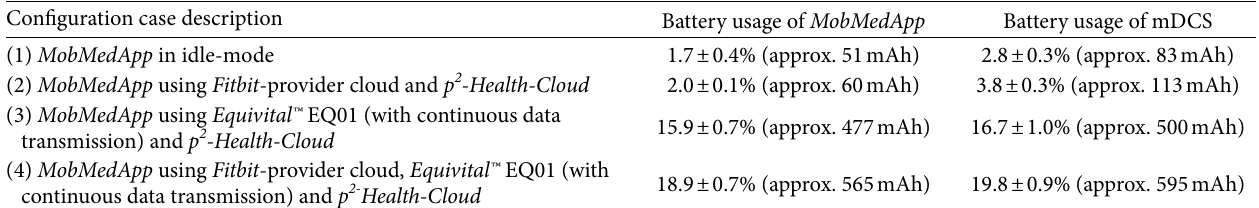
Table 1: Battery usage of mDCS ( MobMedApp ) for different configuration cases over eight-hour measurements using the smart phone Samsung Galaxy S8 (mAh—milli ampere